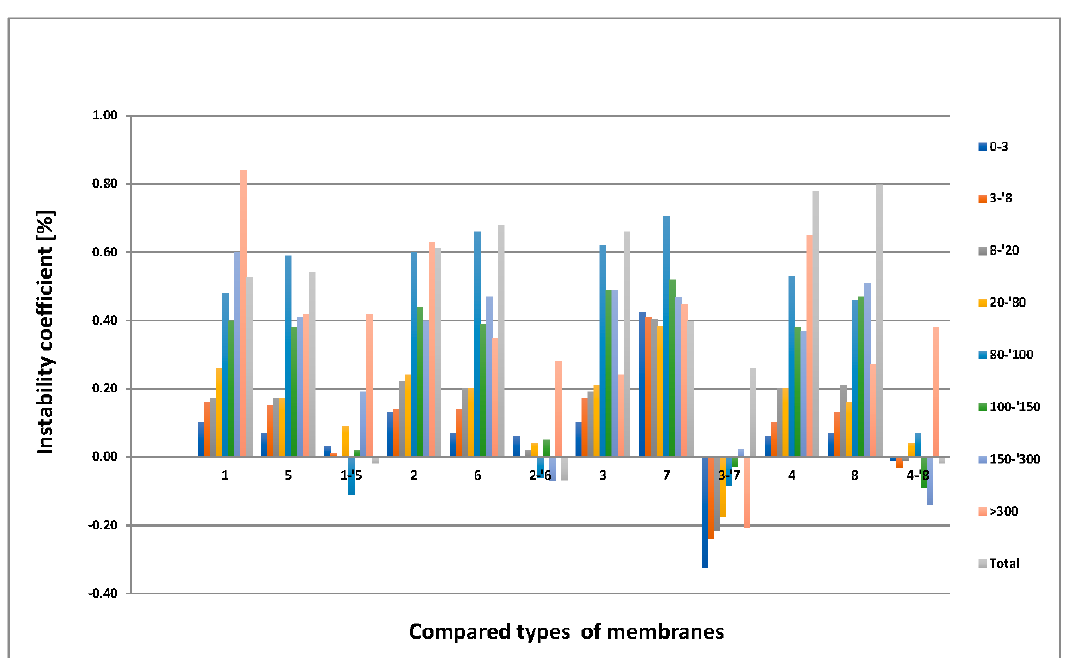
Figure 12. Influence of the addition of pore precursor on the instability of membranes’ porosity in different types and size-classes of pores.